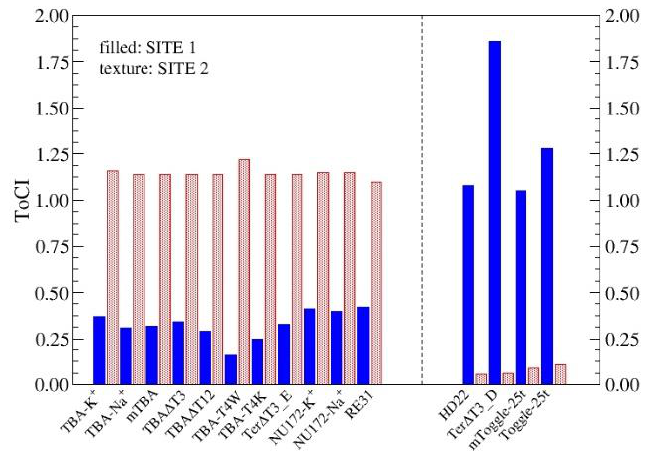
Figure 6. ToCI for the analyzed receptors of α -thrombin. The contacts are put on SITE I (blue) and SITE II (red). Aptamers HD22, ter ∆ T3_D, Toggle-25t, and mToggle-25t bind to SITE 2. Toggle-25t and mToggle-25t are RNA aptamers.